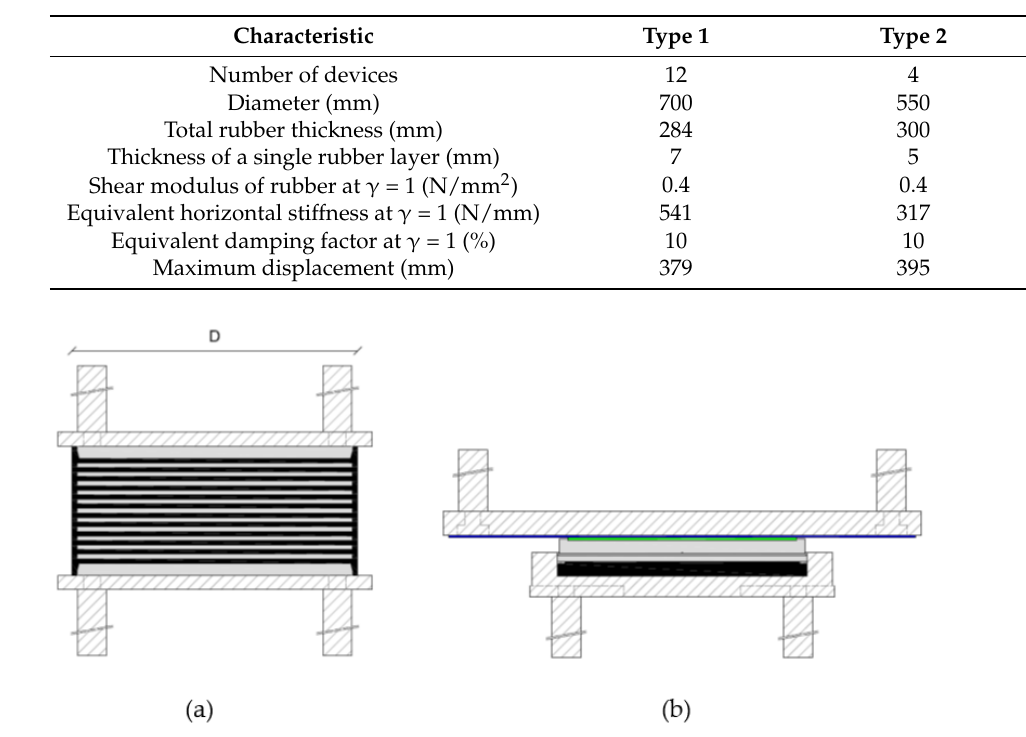
Figure 3. Schematic sections of ( a ) an elastomeric isolator and ( b ) a flat slider device.